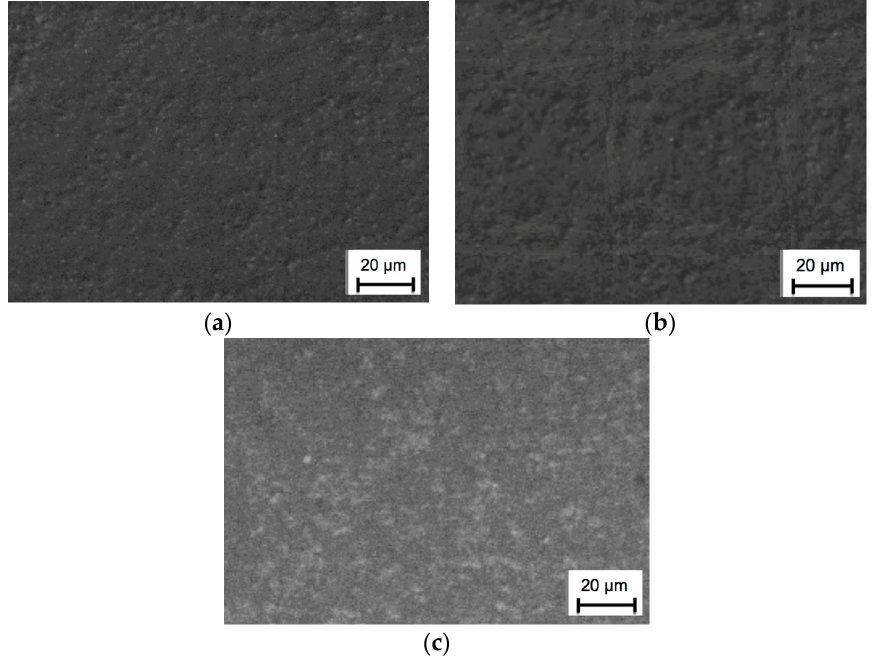
Figure 2. Analyzed surfaces: ( a ) Unimplanted insert surface; ( b ) Surface after yttrium ion implantation (dose 2 × 10 17 ion/cm 2 ); ( c ) Surface after rhenium ion implantation (dose 2 × 10 17 ion/cm 2 ).